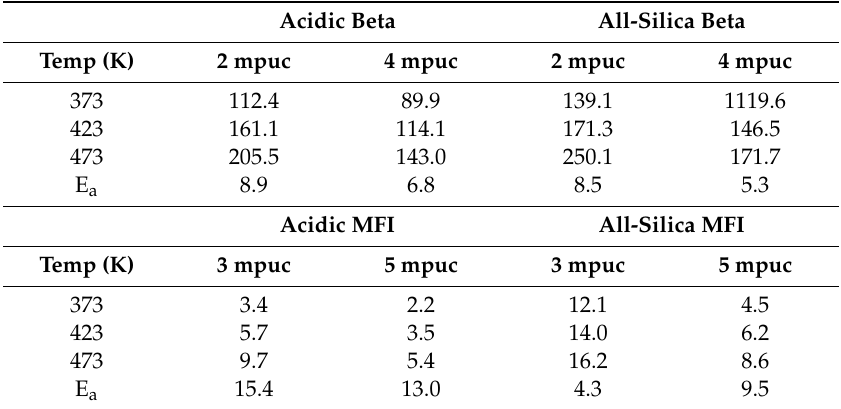
Figure 1. Mean square displacement (MSD) of methanol in zeolite Beta (at loadings of 2 and 4 molecules per unit cell (mpuc)) and zeolite MFI (loadings of 3 and 5 mpuc) at the temperatures 373, 423, and 473 K. Table 1. Self-di ff usion coe ffi cients (D s [ × 10 − 10 (m 2 s − 1 )]) for methanol in zeolites Beta and MFI with the derived activation energies E a (kJ · mol − 1